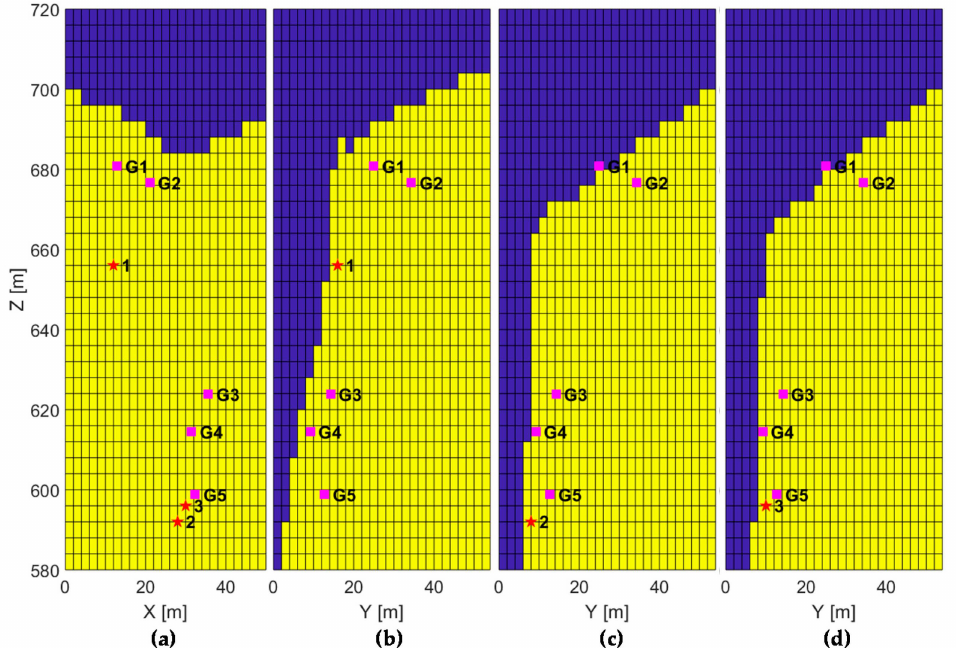
Figure 10. Location results for Rockfall event 5 (Uncertain) presented on vertical slices in the front view ( a ) and side views ( b – d ). The blue area is the air, and the yellow area is the rock mass. Pink squares indicate the five 3C geophones projected on the slice. Red stars indicate the event locations projected on the slice and numbers are used to order the signals according to the arrival times.